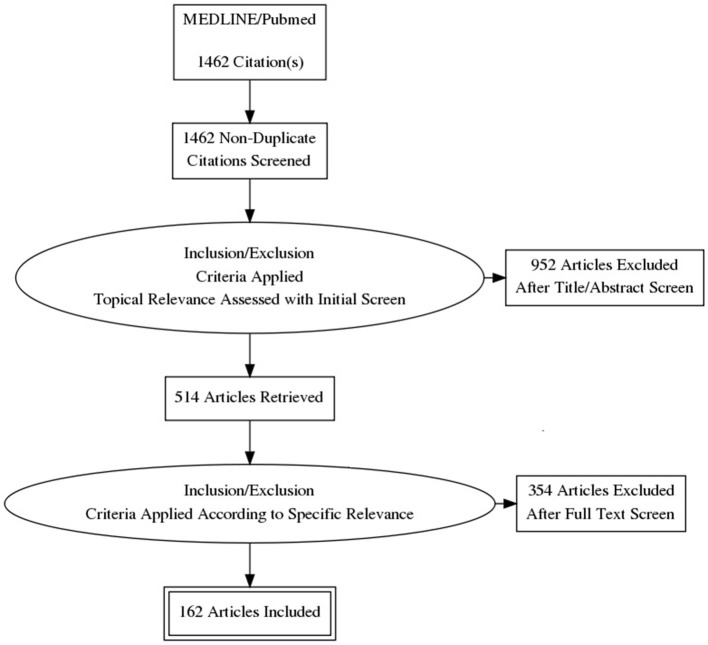
PRISMA flowchart.